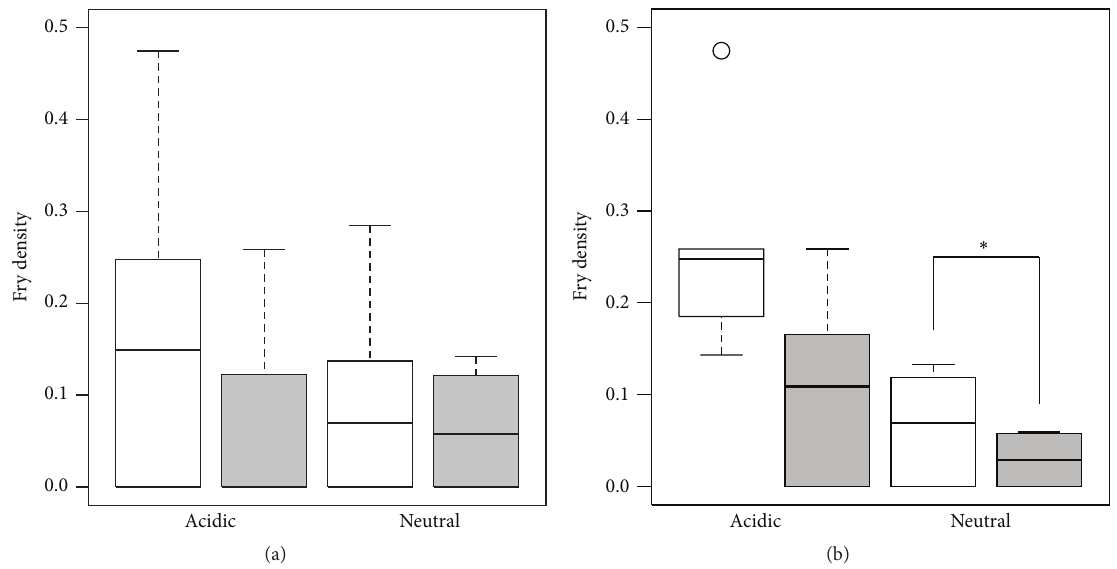
Figure 2: Boxplots showing the median, first and third quartiles, and 95% CI of square root-transformed density estimates (no. m −2 ) of 0 +